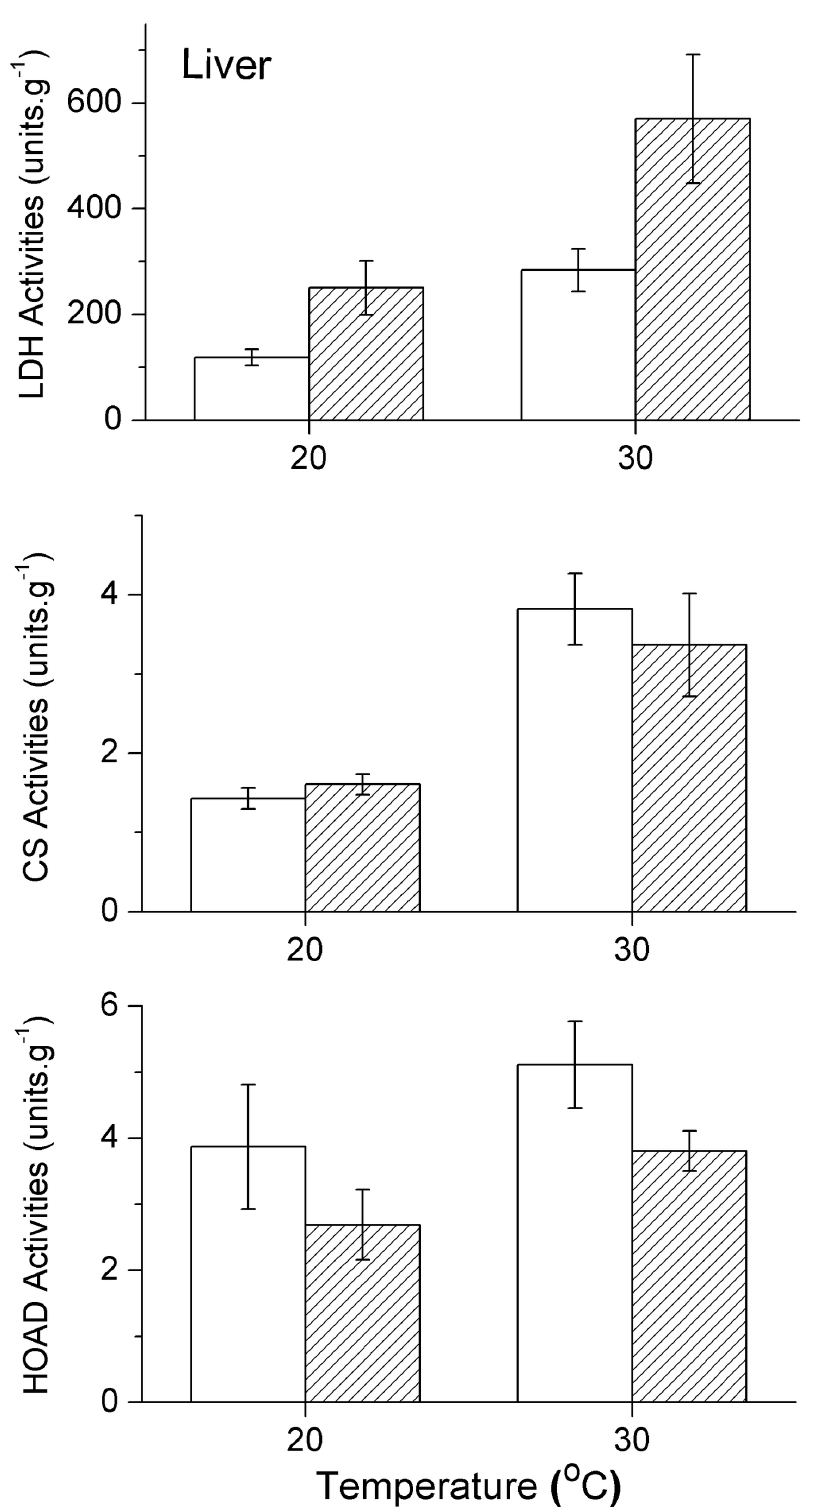
Figure 2. Activities of lactate dehydrogenase (LDH), citrate synthase (CS) and β-hydroxyacyl coenzyme A dehydrogenase (HOAD) at 20 and 30°C in the liver of Phrynocephalus erythrurus (Open columns) and Phrynocephalus przewalskii (Twill columns). Values are means ± s.e.m. doi: 10.1371/journal.pone.0071976.g002 PLOS ONE |